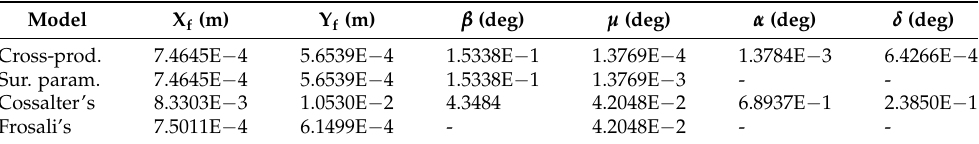
Table 3. Calculation of the RMSE for comparing the kinematic models. The SIMSCAPE MULTIBODY simulation results are set as the reference with a fixed roll angle equal to − 15 (deg). Model X f (m) Cross-prod.